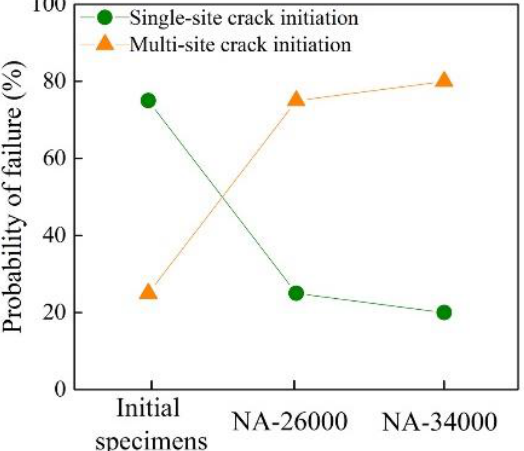
Figure 5. Probability of crack initiation modes for 25CrMo4 specimens after different natural-aging durations.